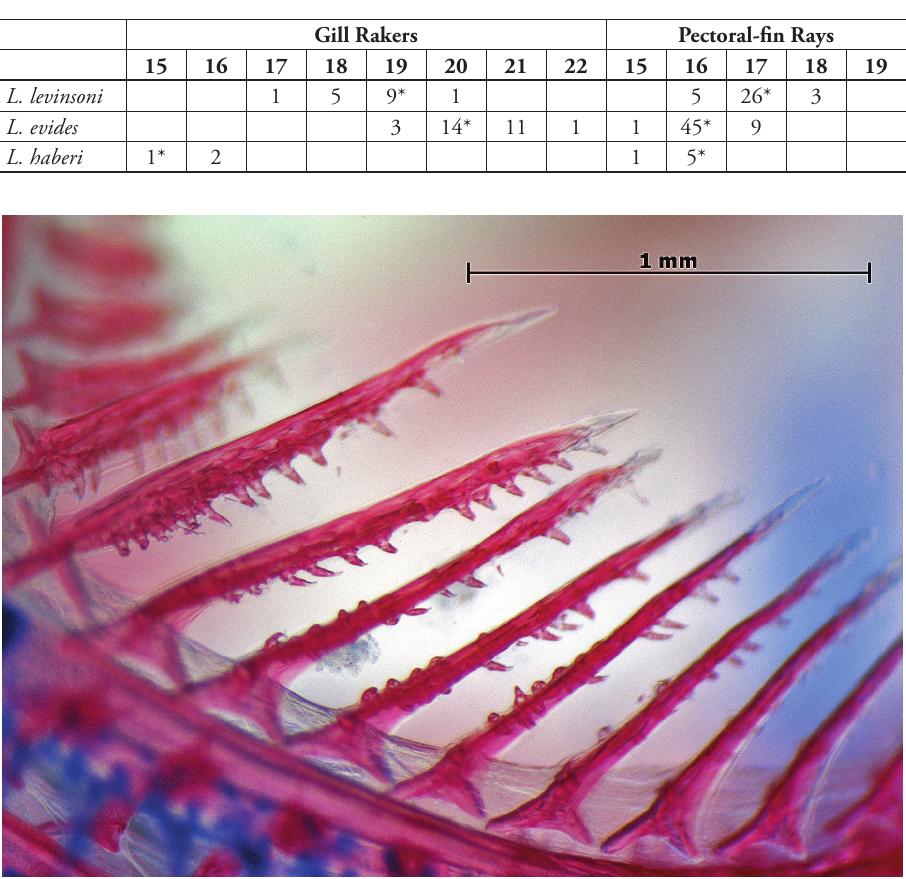
Figure 3. Tooth-like, secondary rakers on the first gill arch in Lipogramma evides , USNM 34771, cleared and stained paratype. Photo by L.